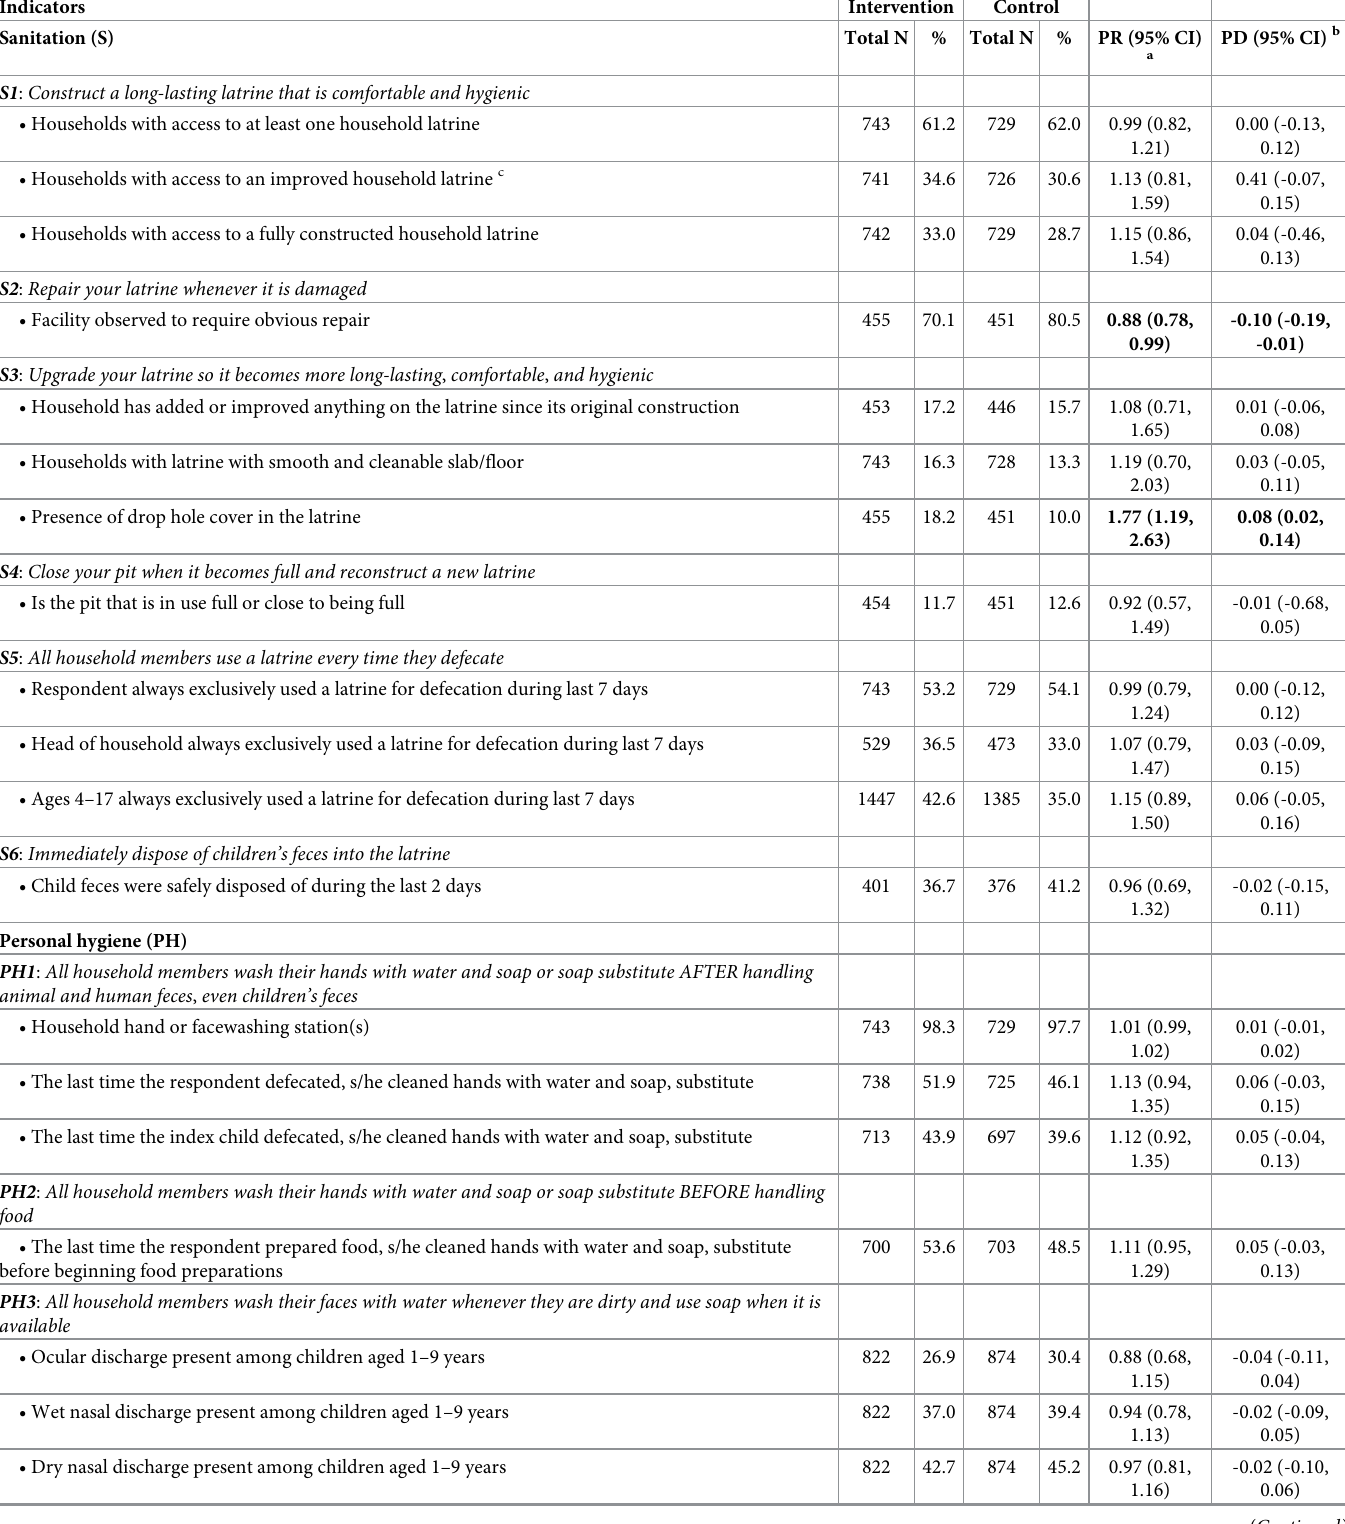
Table 1. Key outcome indicators for WASH behavioral themes and constituent practices of interest of the Andilaye intervention at endline. Indicators